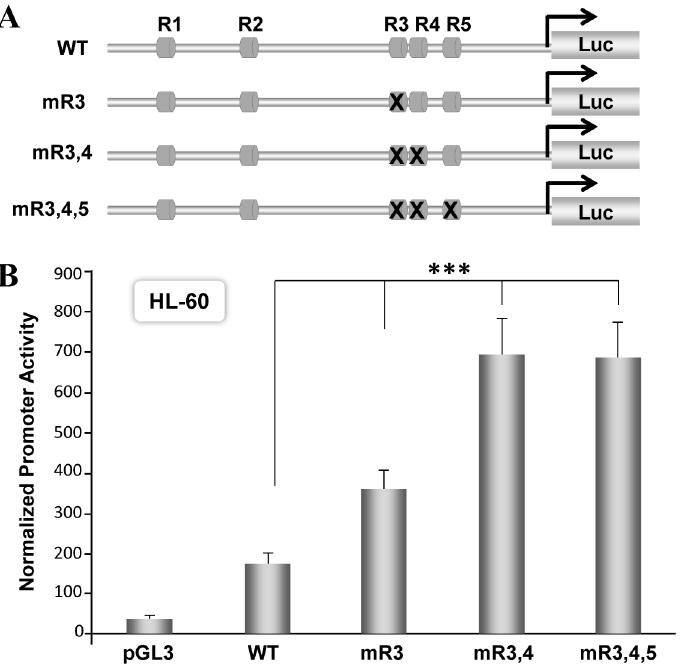
Fig 2. RUNX binding sites within 5 ’ UTR inhibit RUNX1 P1 promoter activity. A) Schematic illustration of the wild type and RUNX sites mutated promoters. Mutant promoters were generated by introducing two base pair substitution mutations in one (mR3), two (mR3,4) or three RUNX sites (mR3,4,5) in the UTR region. Bases selected for mutation in each RUNX binding site are indicated in lower case (AACCACA ! AcaCACA). B) HL-60 cells were electroporated with 200ng of either wild type or mutated promoter reporters. Cells were harvested 18h later and equal amount of cell lysates were evaluated for luciferase activity using the dual luciferase reporter system. Normalized values from four independent experiments with three replicates each are presented in bar graphs with standard error of the mean. Asterisks represent statistically significant increase in basal activity of the RUNX1 mutant promoters compared to wild type promoter ( *** p < 0.001).